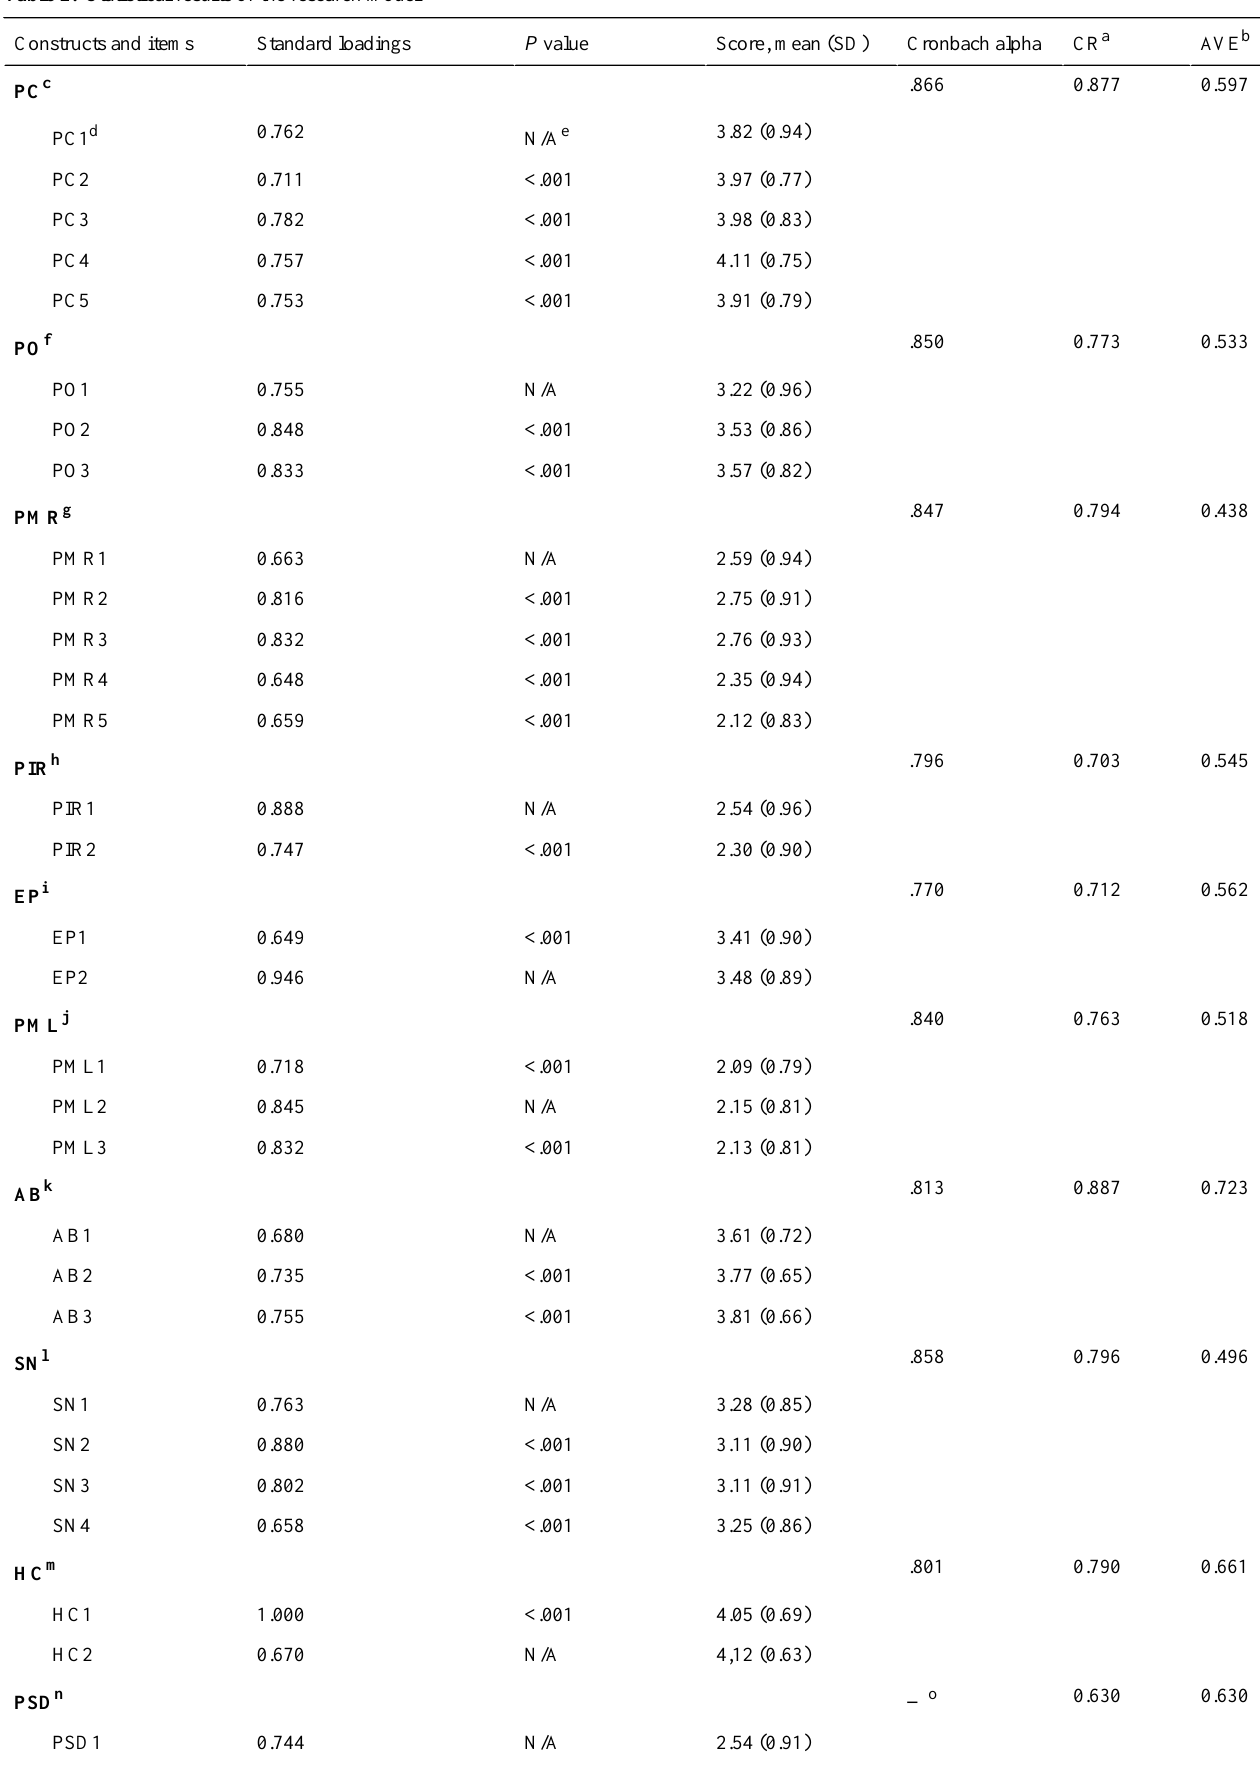
Table 2. Statistical results of the research